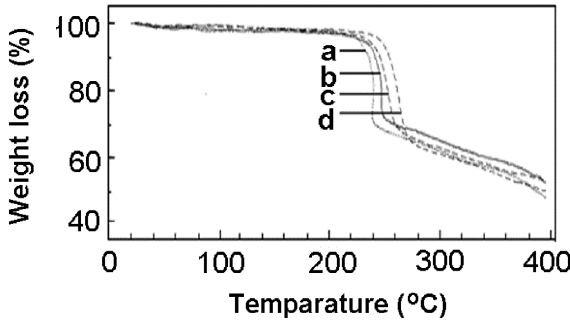
Fig. 4. TGA curves of poly(BMKMA) homopolymer at different heating rates: a) 5 °C/min, b) 10 °C/min, c) 15 °C/min, d) 20